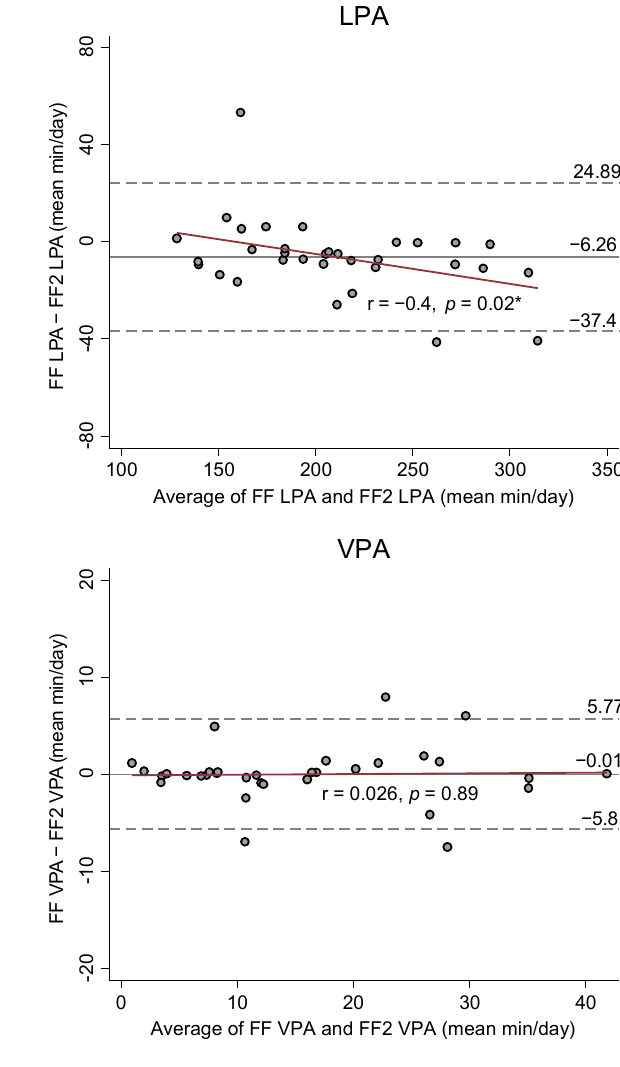
TPA Figure 2. Cont